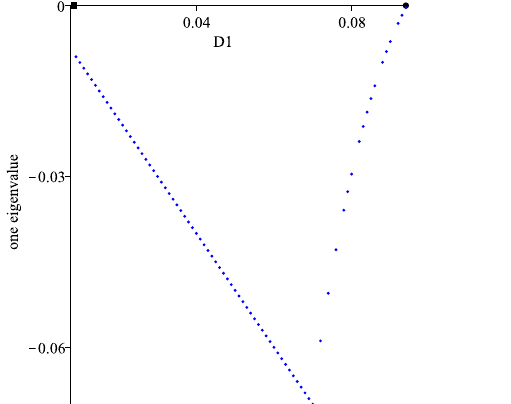
( 1 ) ( 2 ) ) . The solid box and , D 1 1